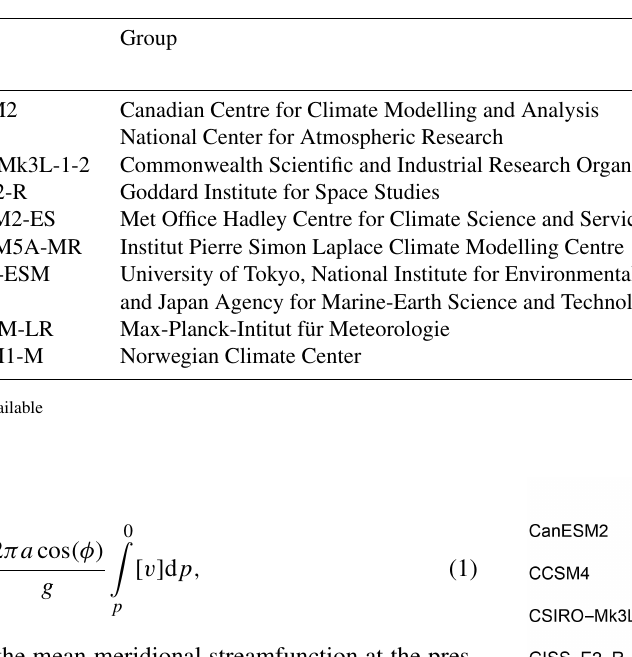
Table 1. The model name, modeling group or agency, the 4 × CO 2 experiment top-of-atmosphere radiative forcing relative to piControl, and the G1 experiment residual top-of-atmosphere radiative forcing relative to the piControl experiment for each of the nine models examined. All radiative forcings are from Huneeus et al. (2014) and are in Wm − 2 . Information on the radiative forcings in the CSIRO-Mk3L-1-2 model is unavailable.